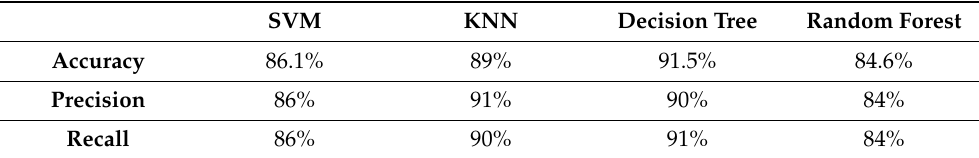
Figure 18. Precision, recall, F1-score, and accuracy values for each classifier model. Table 9. Accuracy values of Machine Learning classifiers.